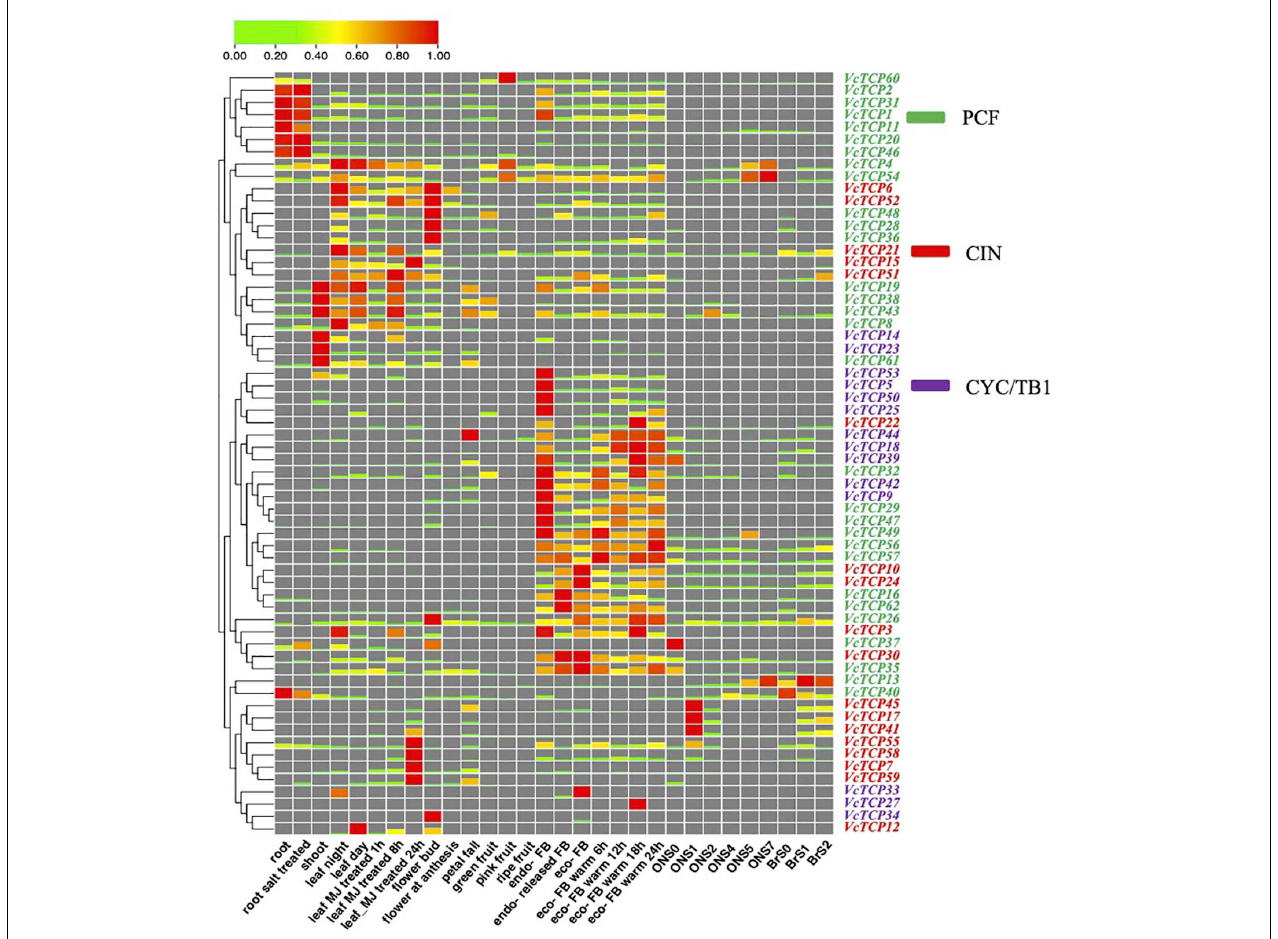
FIGURE 6 | Expression profiles of VcTCP genes in diverse tissues, stages of fruit development, flower bud dormancy release, and in response to hormone treatment. The mean expression values were calculated using zero to one. Genes and expression patterns were hierarchically clustered based on the average Pearson’s metric. Green and red boxes show low and high expression levels, respectively, for every gene. Different colors of gene name belong to class I, CIN, and CYC/TB1, respectively. BrS0, S1, and S2 indicated the early fruit developmental stages of the blueberry variety “Blue rain”; ON S0–S7 indicated the whole fruit development of the blueberry variety ‘O'Neal.’ FB means flower bud. Leaf MJ-treatment: leaf methyl jasmonate (MeJA) treatment. Endo- means endo-dormancy; eco- means